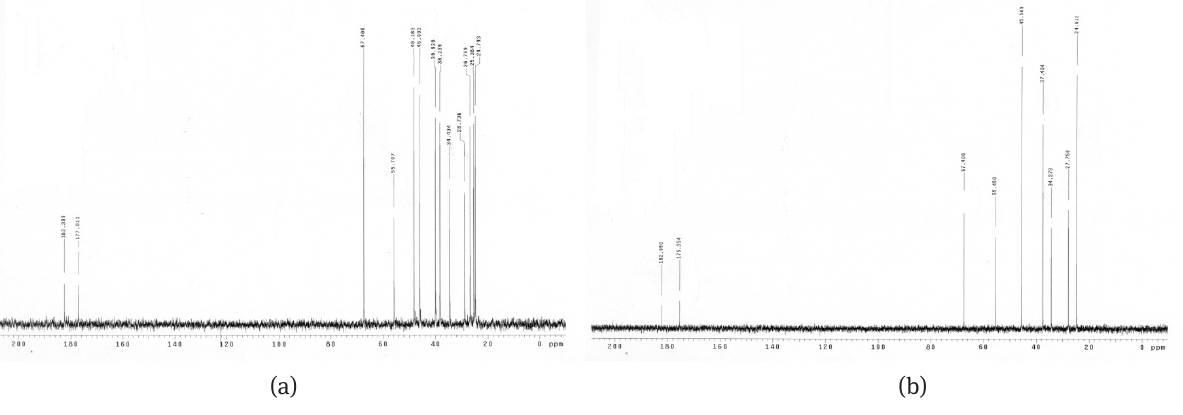
(3,3-tri) pH=6.0 and b). (Glu)H 4